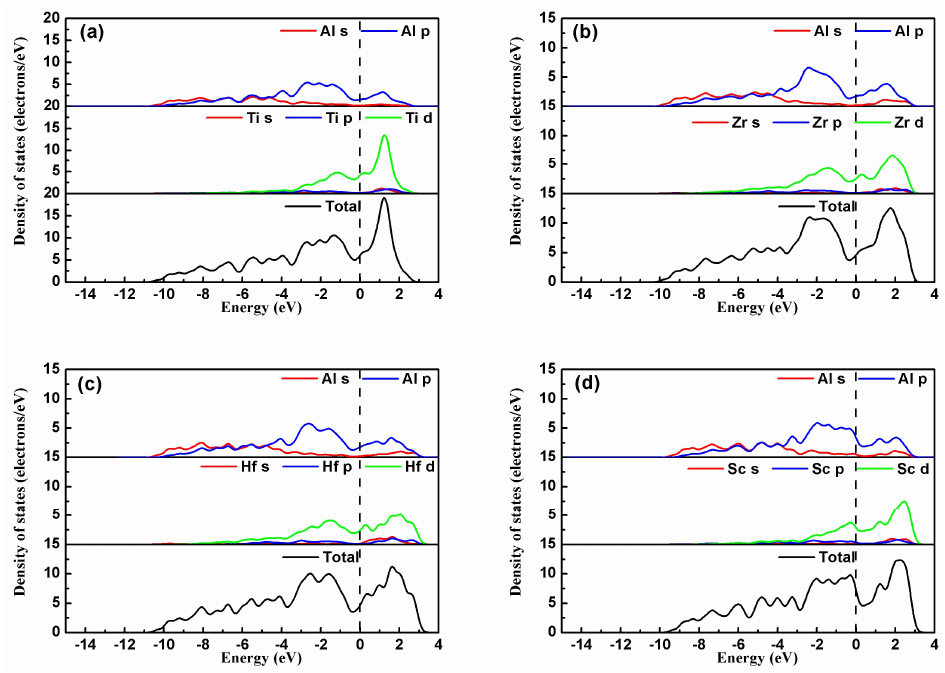
Figure 6. The partial density of states of ( a ) Al 3 Ti, ( b ) Al 3 Zr, ( c ) Al 3 Hf, and ( d ) Al 3 Sc.